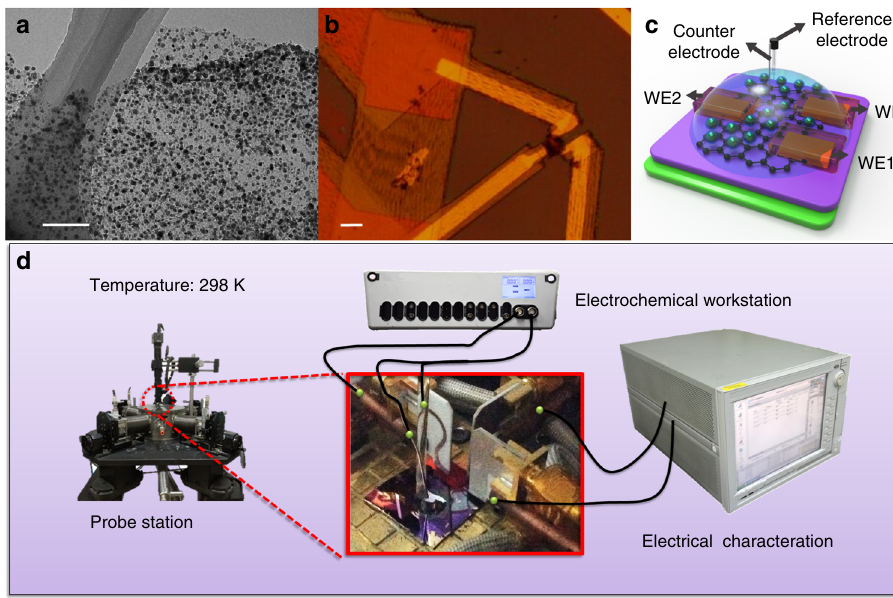
Fig. 1 Working principle of temporal electrical transport measurement. a TEM image of as-prepared Ni-graphene nanosheets with a scale bar at 200 nm. b Optical microscope image of nanosheets contacted with three metallic electrodes with a scale bar at 10 μ m. c Schematic illustration of the Ni-graphene nanosheet-based device with a microscopic electrochemical cell on it. d Illustration of the device ( inset ) and corresponding measurement equipment layout with the three-dimensional